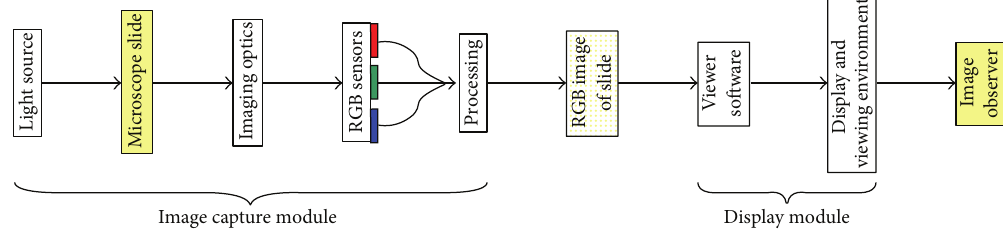
Figure 1: WSI image processing.